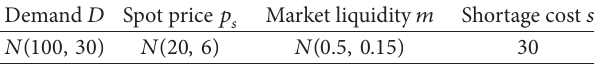
Table 1: Parameters for numerical studies. Table 2: Effect of correlation between spot market price and